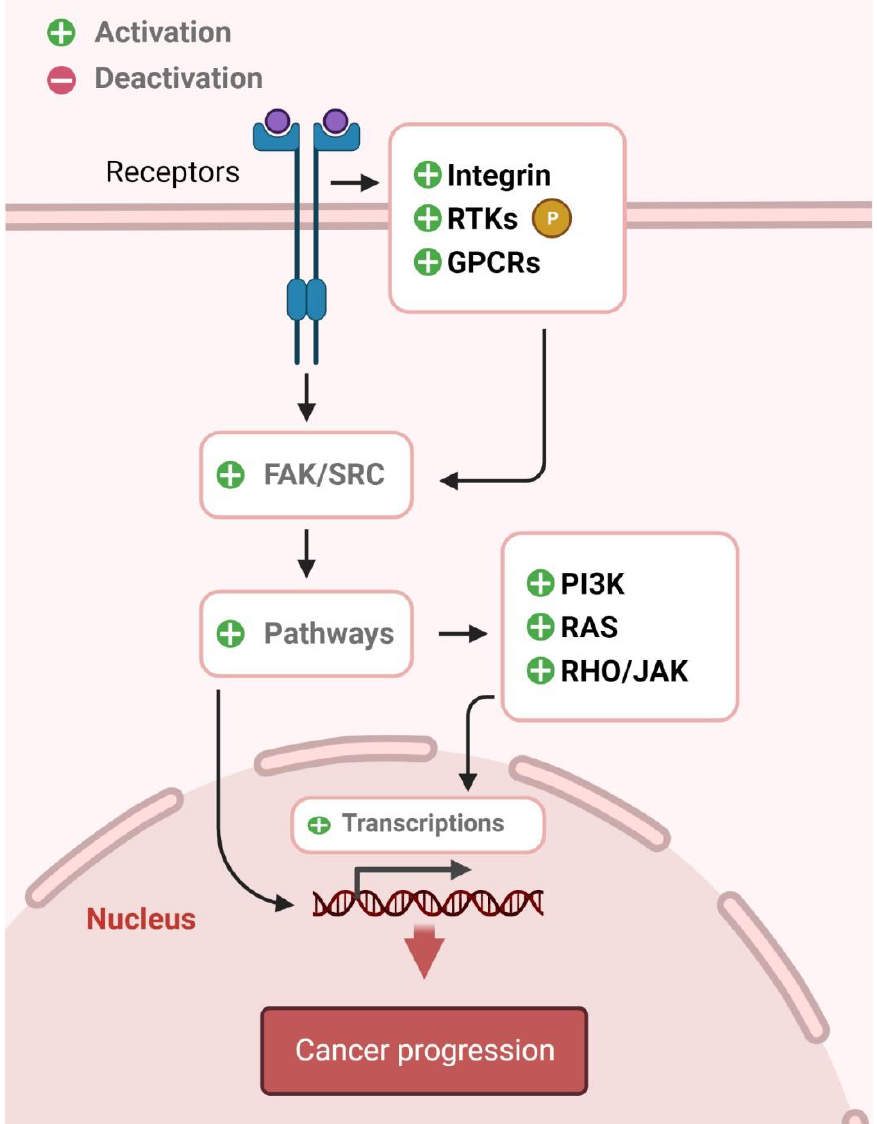
Figure 5. Upstream stimuli of Src and its downstream target molecules. Src interacts with integ- rin/focal adhesion kinase (FAK), the receptor of tyrosine kinases (RTKs), and G-protein-coupled receptors (GPCRs), leading to activation of its downstream target proteins, including MAPK/ERK, PI3K, IL-6/JAK/STAT3, and Rho/Rho-associated protein kinase (ROCK), subsequently promoting cancer progression.